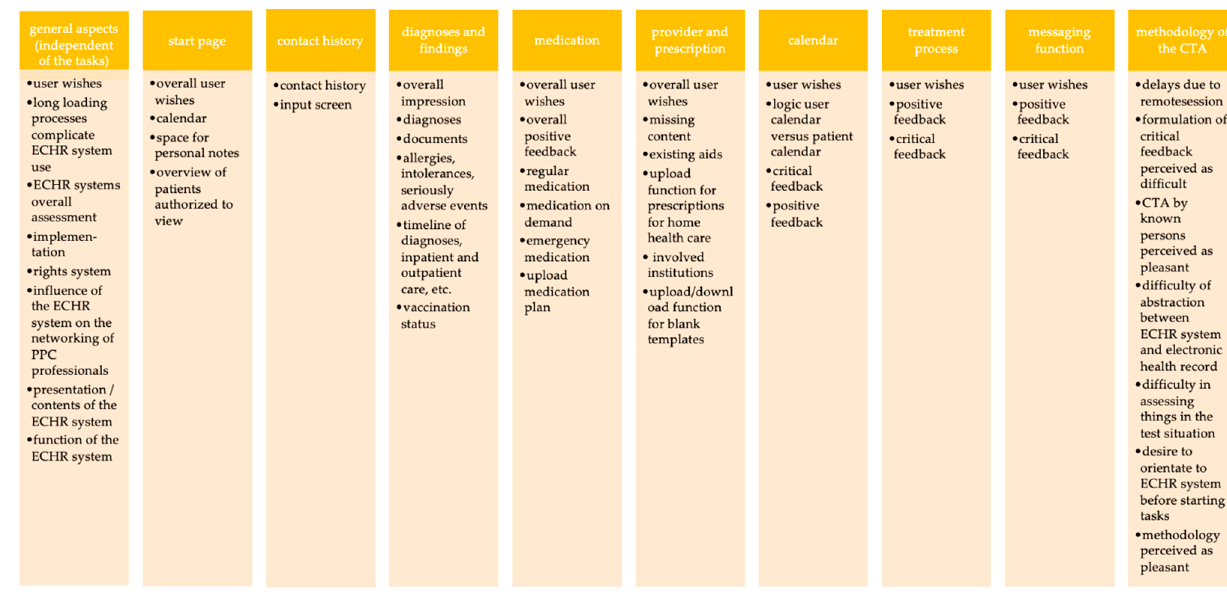
Figure 3. Overview of the main categories and subcategories.